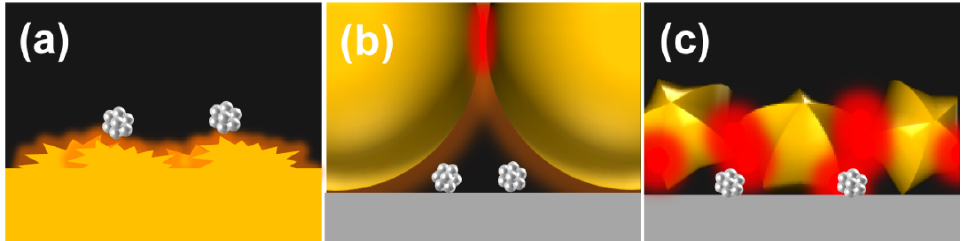
Figure 1. Enhanced Raman spectroscopy for the detection of subnano-particles. Schematics of ( a ) surface-enhanced Raman spectroscopy at a roughened metallic surface, ( b ) optimised shell-isolated nanoparticle enhanced Raman spectroscopy using 120 nm diameter Au nanoparticles as optical amplifiers, ( c ) enhanced Raman spectroscopy with shell-isolated nanostars which produce an abundant proportion of hotspots at the surface that allow detection of single molecules and small particles.